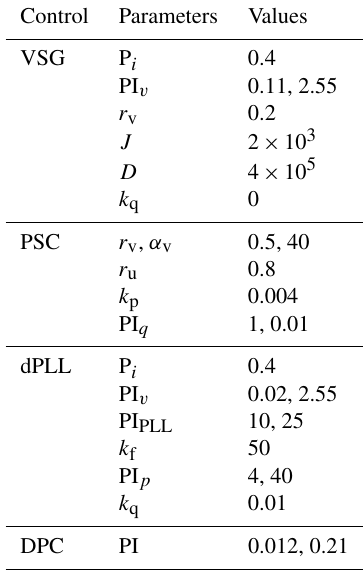
Table A2. Tuned control parameter values in per